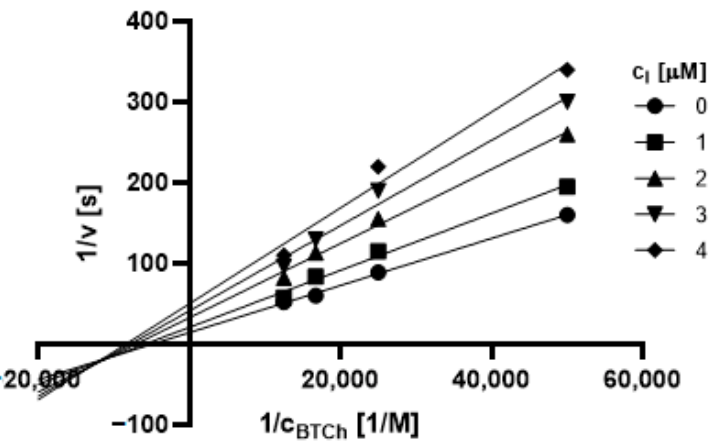
Figure 12. Lineweaver–Burk plot for 2a and BuChE inhibition (BTCh = butyrylthiocholine).